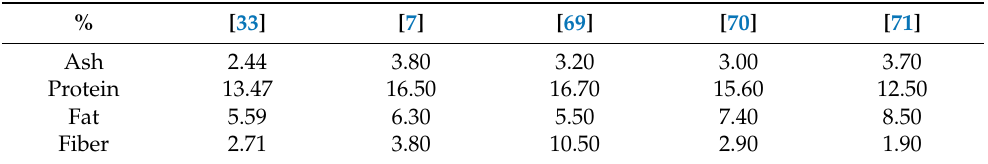
Table 2. Comparative proximate analysis of UAF-Q7 quinoa cultivar based on published re- ports [7,33,69–71].